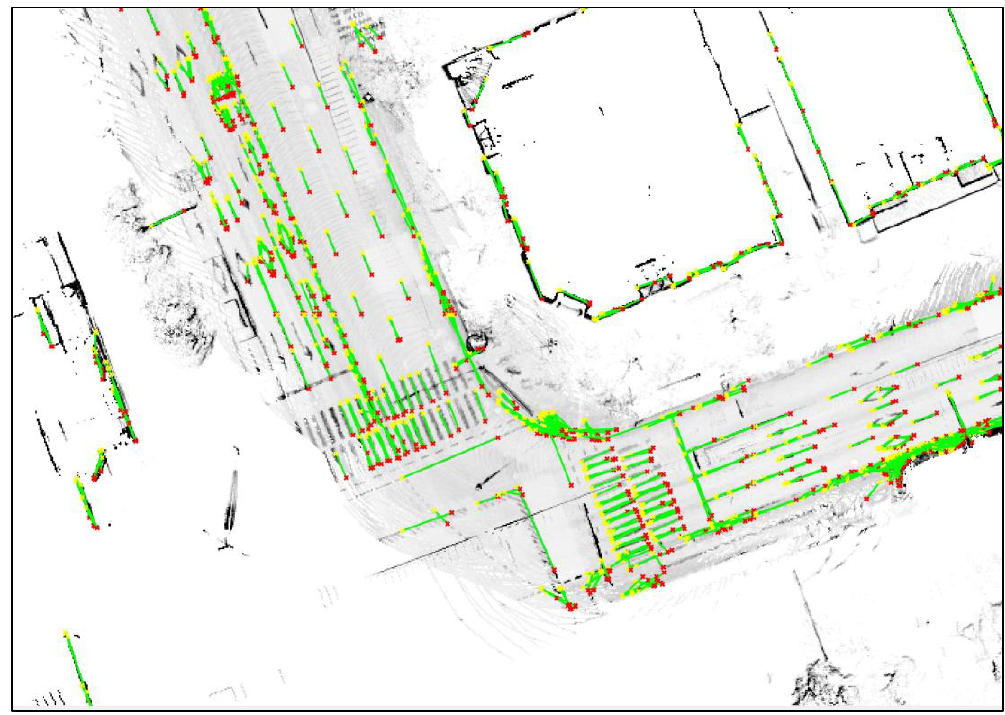
Figure 18. Generated ELM (on synthetic map).